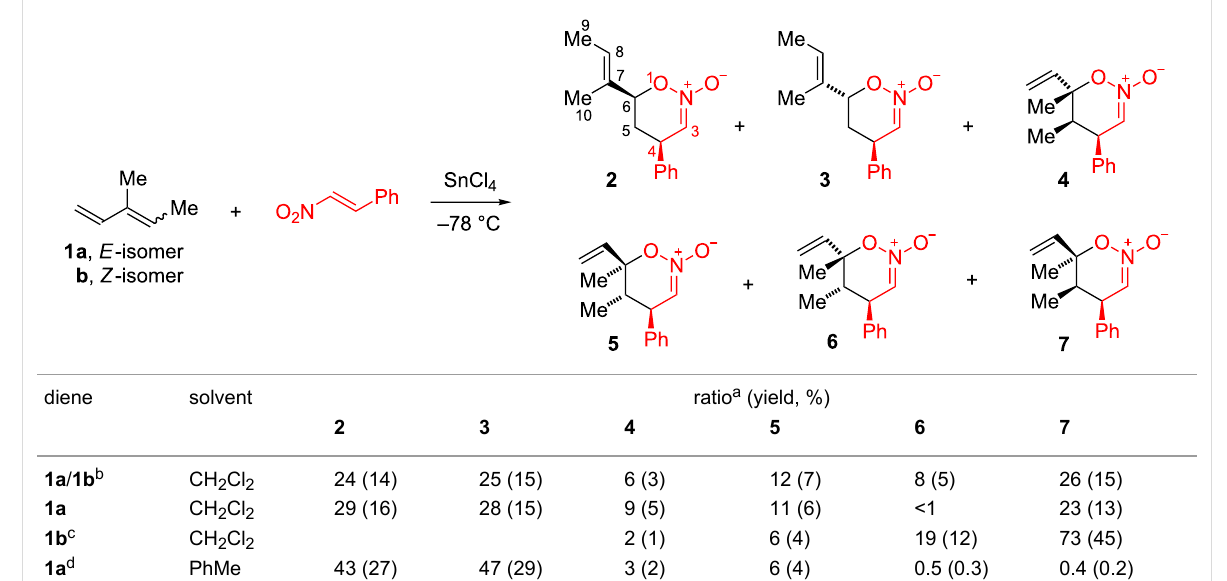
Table 1: Cycloaddition products for Sn(IV)-catalyzed reaction of 3-methyl-1,3-pentadiene with β -nitrostyrene.